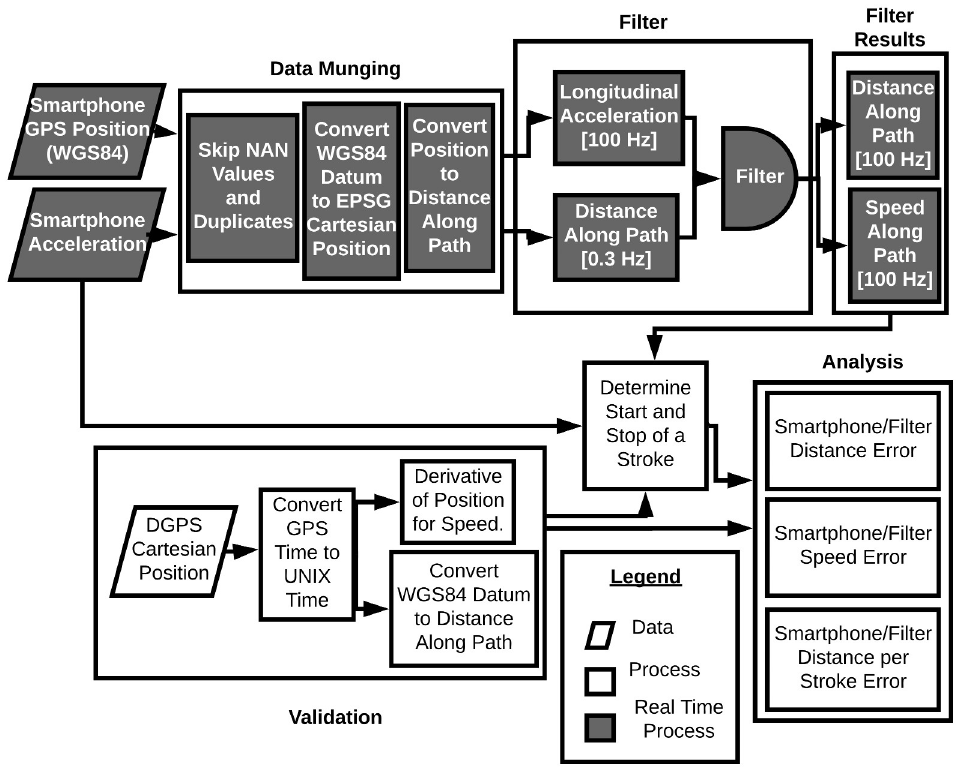
Fig 1. Data processing pipeline flow chart. Grey rectangles indicate the real-time algorithm process. White rectangles indicate the validation process. Parallelograms represent raw data from the sensors.